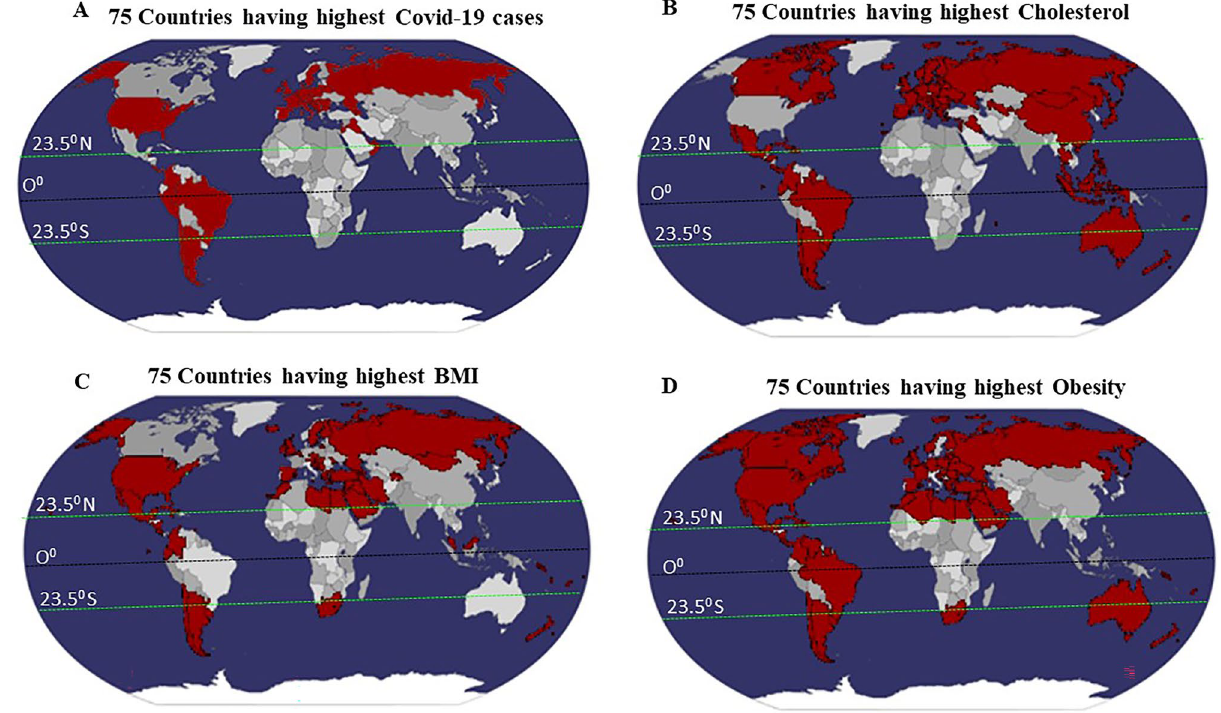
Figure 1. Geographical distribution of the 75 countries with the highest (A) total Covid-19 cases per million. (B) Average total cholesterol (ATC). (C) BMI and (D) obesity. Brown color-marked in the map shows the topmost 75 countries with highest total cases per million, ATC, BMI and obesity. Here, Tropic of Cancer (23.5° N), Tropic of Capricorn (23.5° S) and 0° latitudes are shown on a world map. The freely available online server (worldmapmaker.com) was used to make world